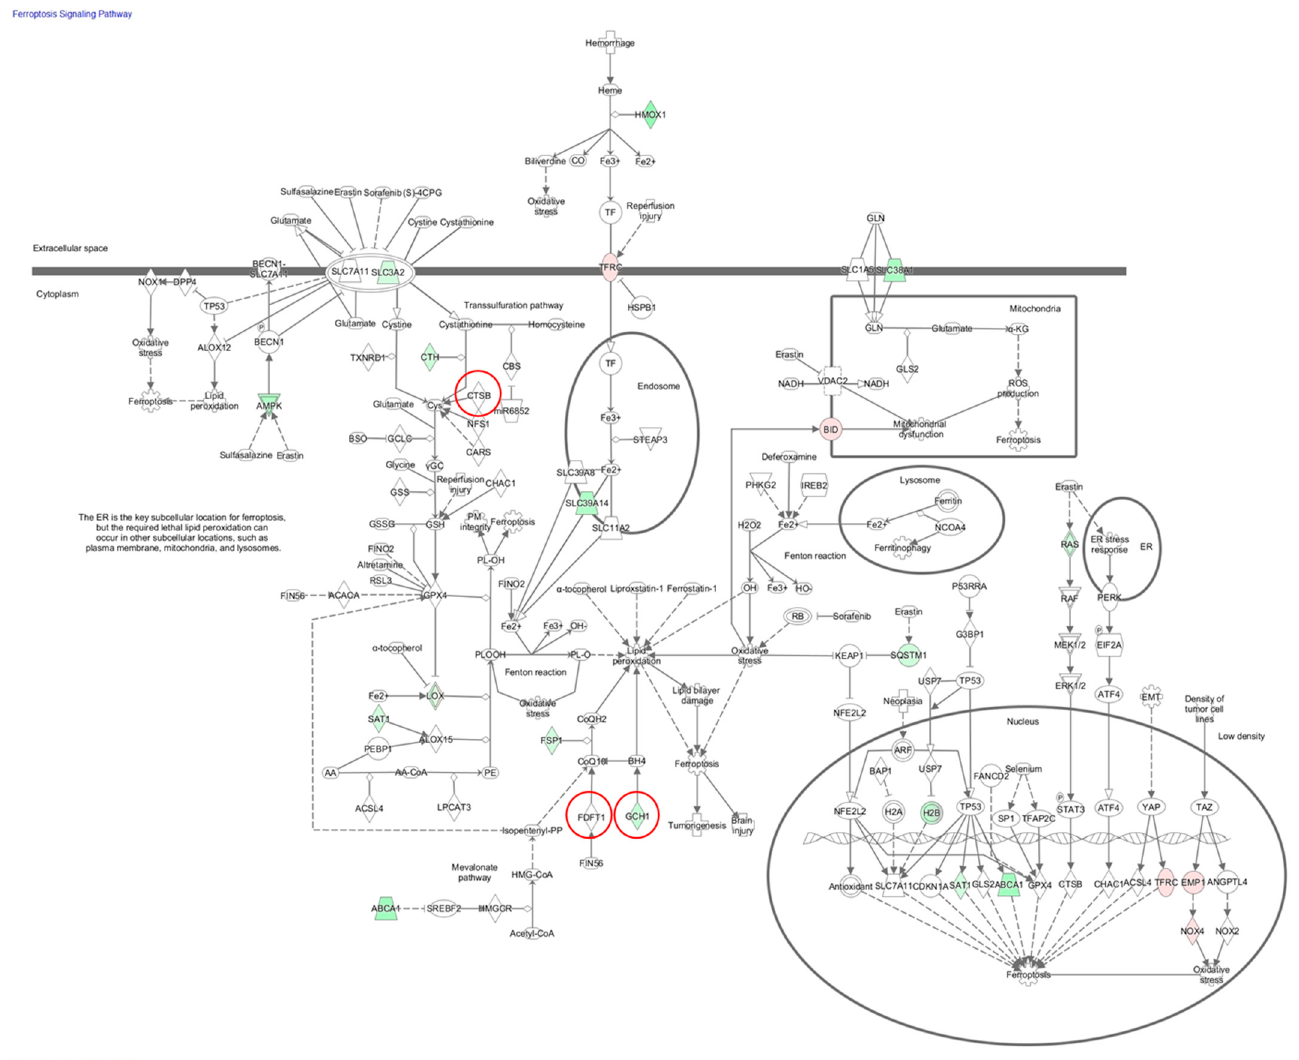
Figure 2. Ferroptosis signaling pathway using IPA. The three red circled genes are listed in the genes from the Japanese GWAS. The genes with pink background are upregulated in OA, and those with green background are downregulated in OA. IPA: ingenuity pathway analysis; GWAS: genome-wide association study; OA: osteoarthritis.